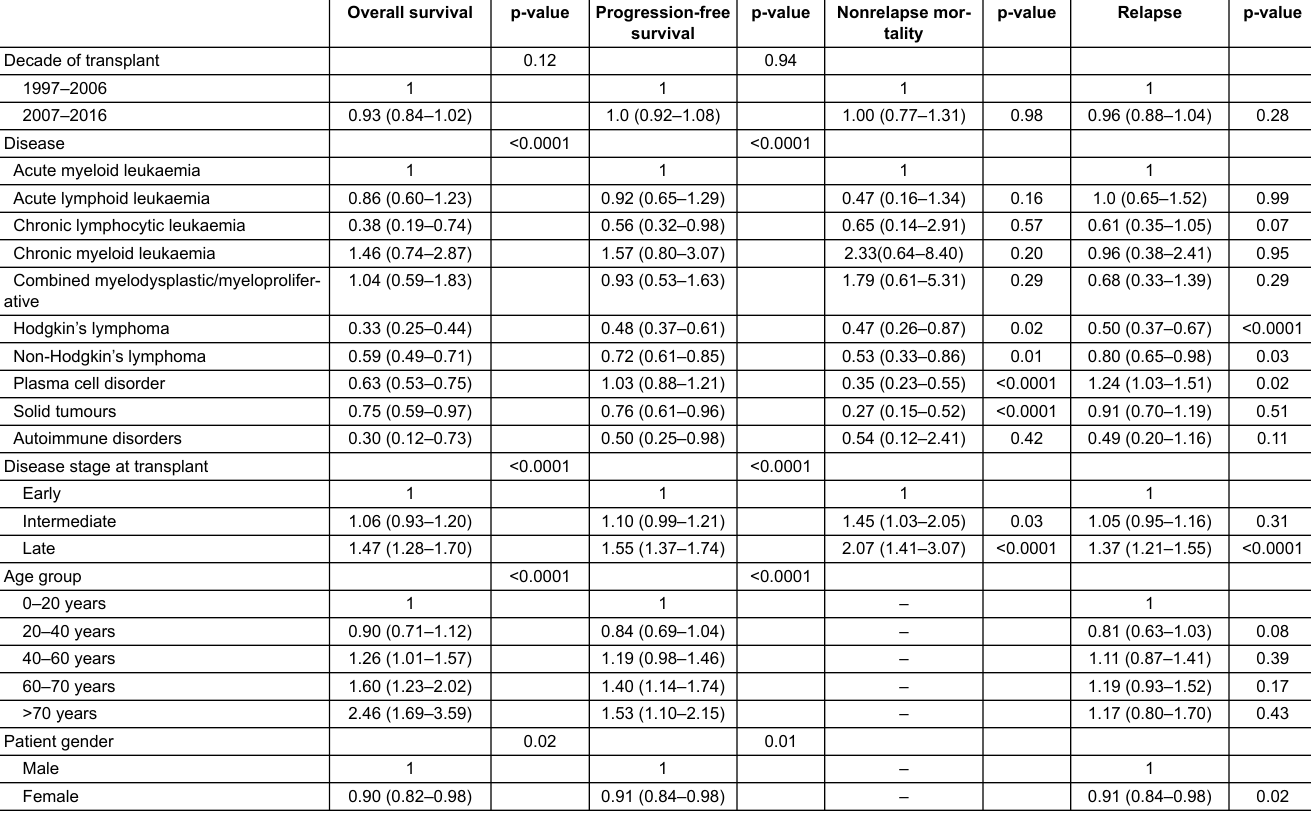
Table 3b: Multivariate analysis of overall survival, progression free survival, nonrelapse mortality and relapse for autologous haematopoietic cell transplants for the years